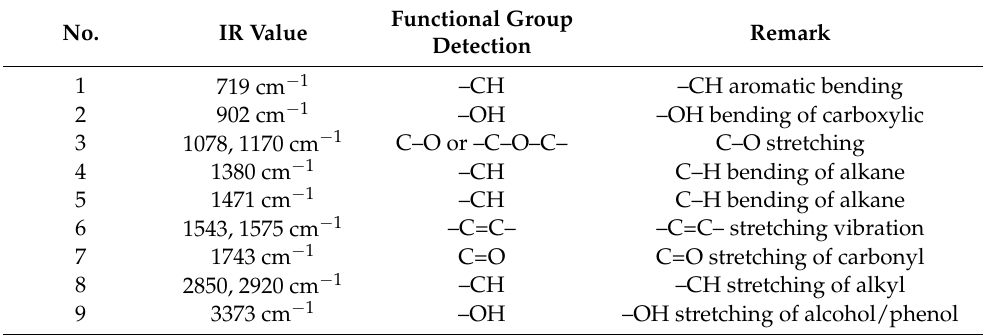
Figure 3. The FTIR spectra of both B. flexuosa methanolic extract and the synthesized AgNPs in the range of 400–4000 cm − 1 , with a resolution of 4 cm − 1 , and using FTIR (Shimadzu, Kyoto, Japan). Table 2. FTIR spectral characteristics of AgNPs synthesized by B. flexuosa